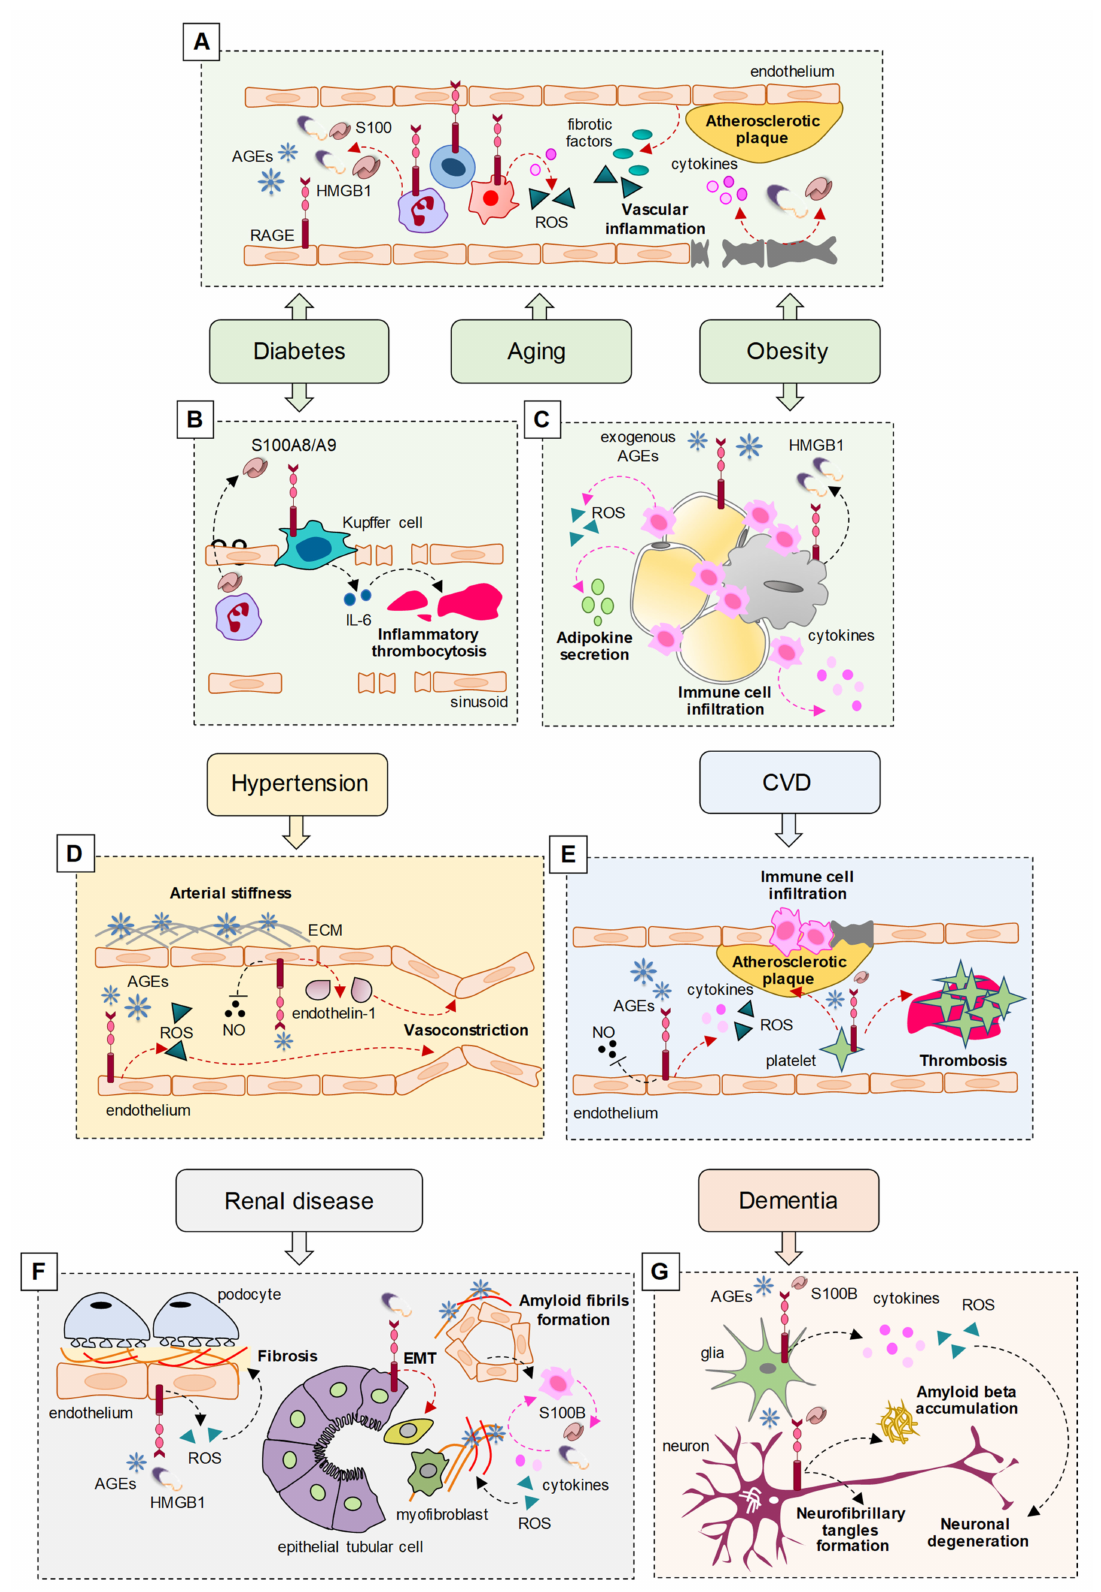
Figure 1. ( A ) In diabetes, obesity, and aging conditions, RAGE, expressed at high levels in activated immune cells and endothelial cells, is overstimulated by elevated serum levels of RAGE ligands (i.e., AGEs, HMGB1, and S100 proteins) leading to oxidative stress (OxS) and the release of cytokines and fibrotic factors, thus predisposing patients to vascular inflammation and atherosclerosis. ( B ) In diabetes, RAGE expressed on hepatic Kupffer cells is stimulated by neutrophil- derived S100A8/A9, resulting in IL-6-dependent inflammatory thrombocytosis. ( C ) In obesity, necrotic adipocytes